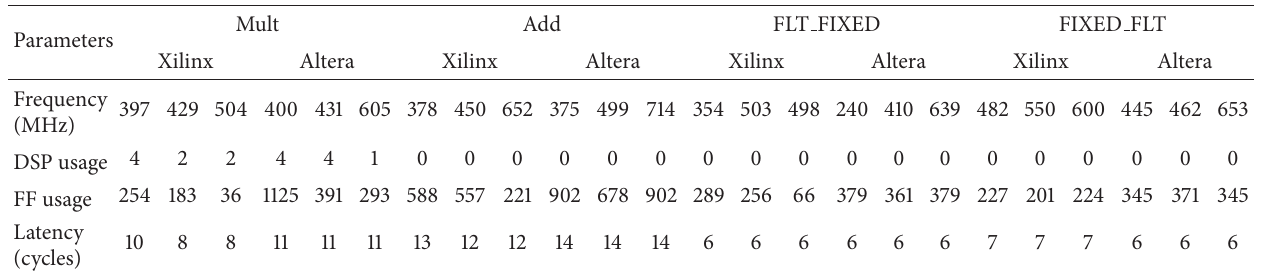
Table 2: Parameter values for selected core instances in case